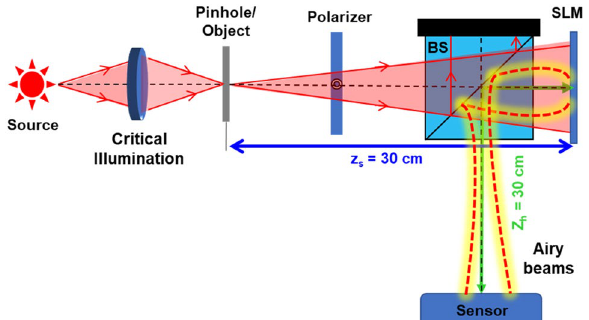
Figure 4. Schematic of the experimental setup. An object is critically illuminated using an incoherent source, and the light from the object is incident on an SLM through a BS. The phase mask displayed on the SLM converts the incident light into a sparse random array of Airy beams, which is captured by an image sensor. BS—beam splitter; SLM—spatial light modulator; z s —distance between object and SLM; z h —distance between SLM and sensor.